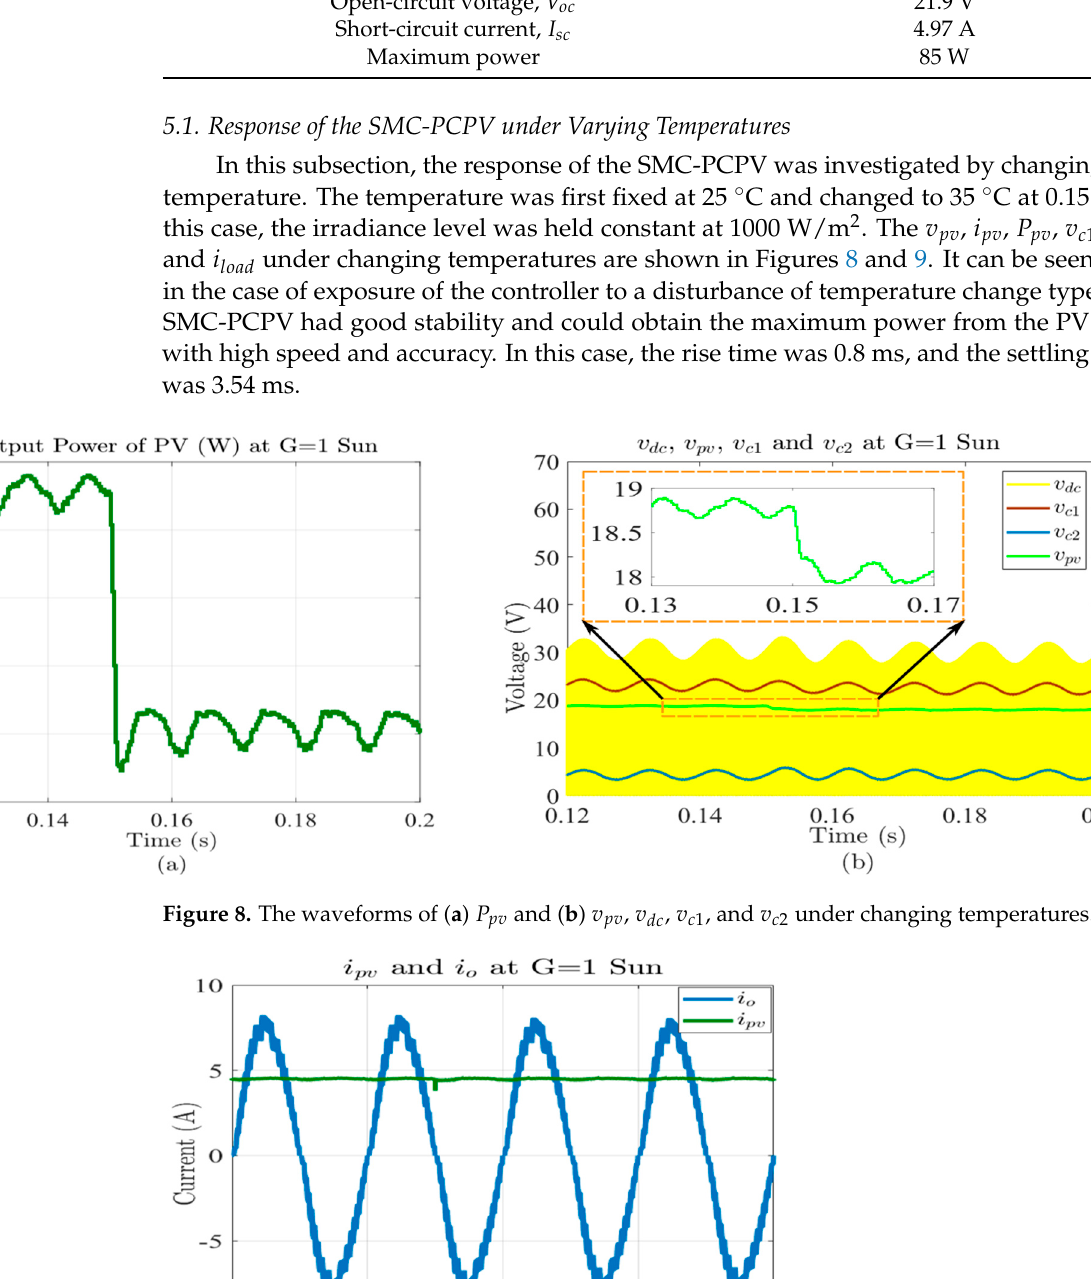
Figure 7. Prototype of the single-phase qZSI.